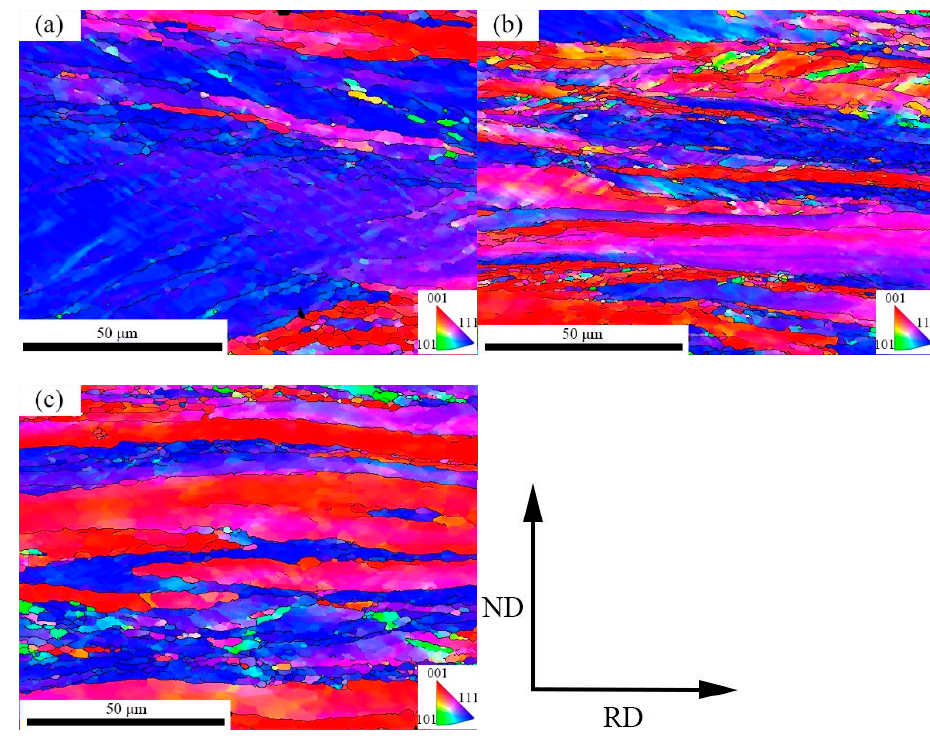
Figure 6. EBSD center IPF orientation maps of samples rolled with different reduction rates ( a ) 800 ◦ C—88%, ( b ) 800 ◦ C—78%, ( c ) 800 ◦